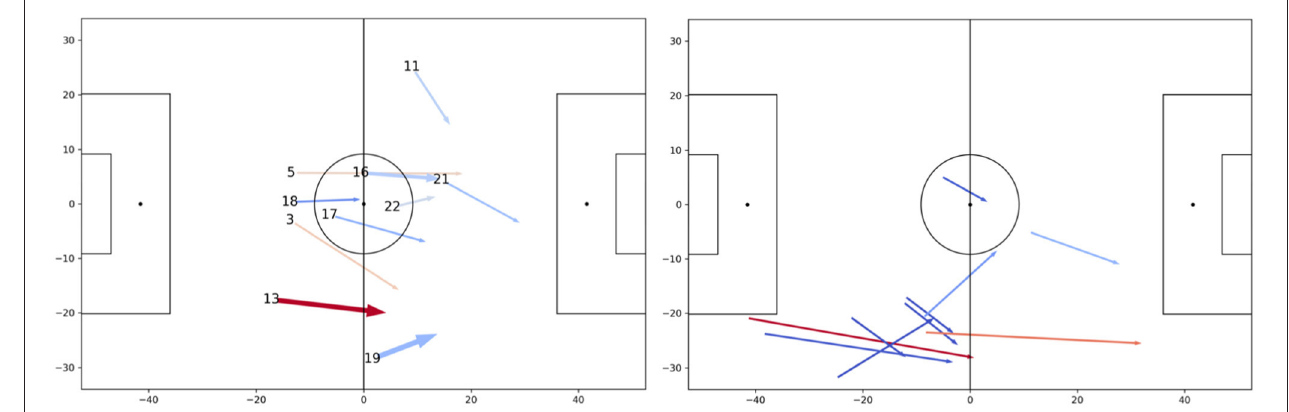
FIGURE 12 | (Left) Average passes to player 6. (Right) Passes from 13 to 6.